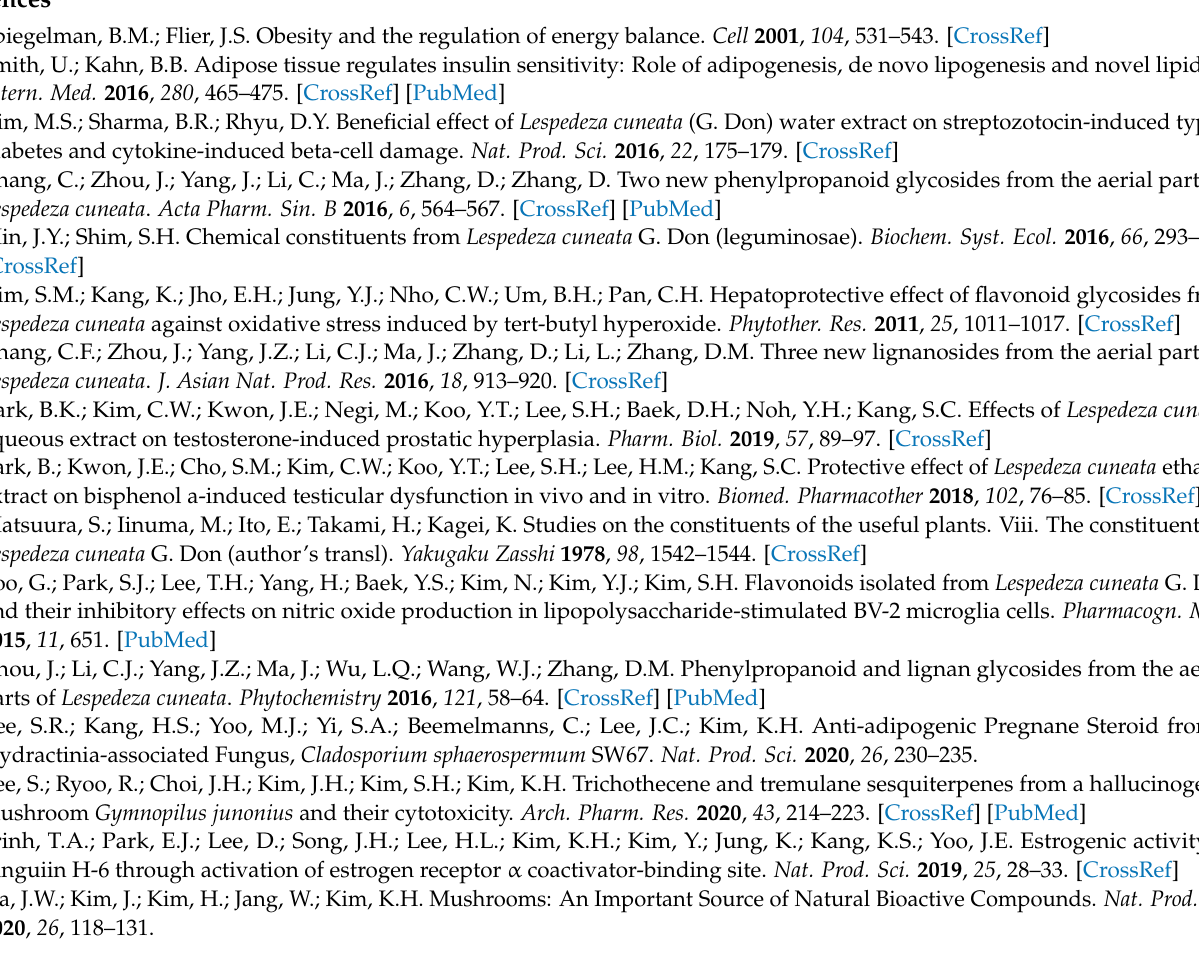
set as 254 nm) of compound 1 , Figure S4: 1 H-NMR spectrum of compound 2 (in CD 3 OD), Figure S5: LC/MS data (detection wavelength was set as 315 nm) of compound 2 , Figure S6: 1 H-NMR spectrum of compound 3 (in CD 3 OD), Figure S7: LC/MS data (detection wavelength was set as 315 nm) of compound 3 , Figure S8: 1 H-NMR spectrum of compound 4 (in CD 3 OD), Figure S9: LC/MS data (detection wavelength was set as 210 nm) of compound 4 , Figure S10: 1 H-NMR spectrum of compound 5 (in CDCl 3 ), Figure S11: 13 C-NMR spectrum of compound 5 (in CDCl 3 ), Figure S12: LC/MS data (detection wavelength was set as 210 nm) of compound 5